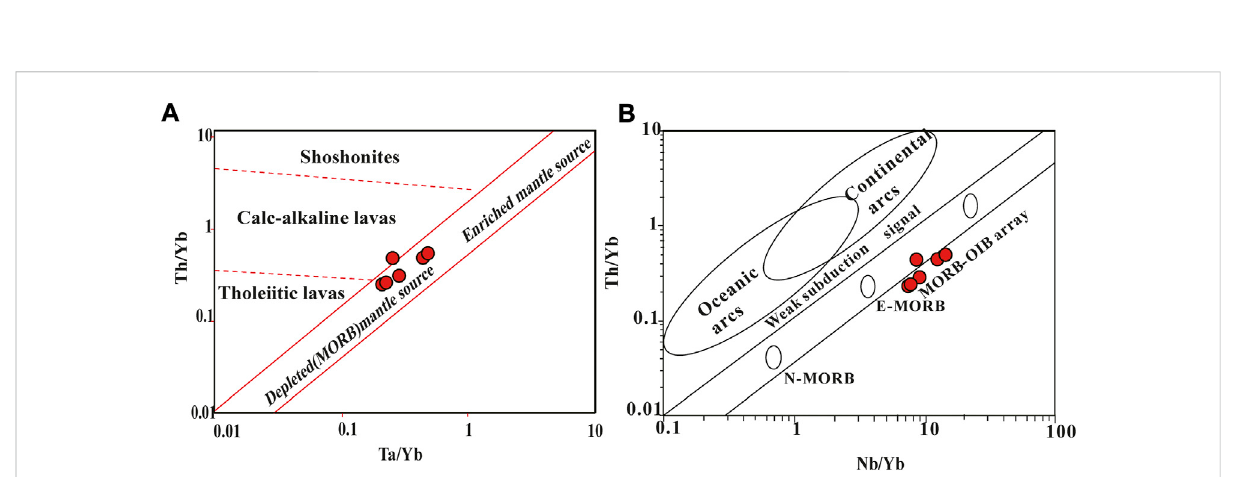
FIGURE 12 (A) Th/Yb-Ta/Yb(Alabasteretal.,1982)and (B) Th/Yb-Nb/Ybdiagrams(Pearce,2008).Redcirclerepresentstheamphibolite;E-MORB,enriched mid-ocean ridge basalt; MORB, mid-ocean ridge basalt; N-MORB, normal mid-ocean ridge basalt; OIB, ocean island